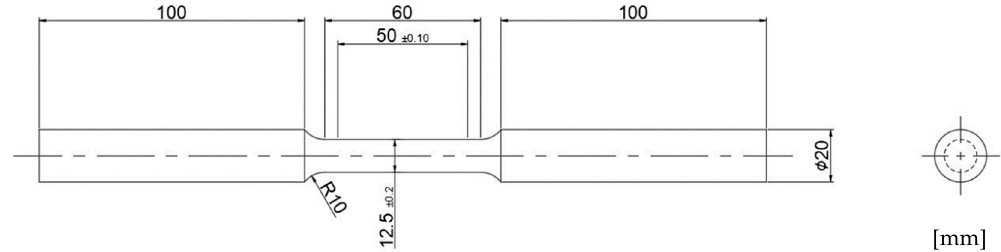
Figure 2. Standard 12.5 mm round tension test specimen of ASTM E8.